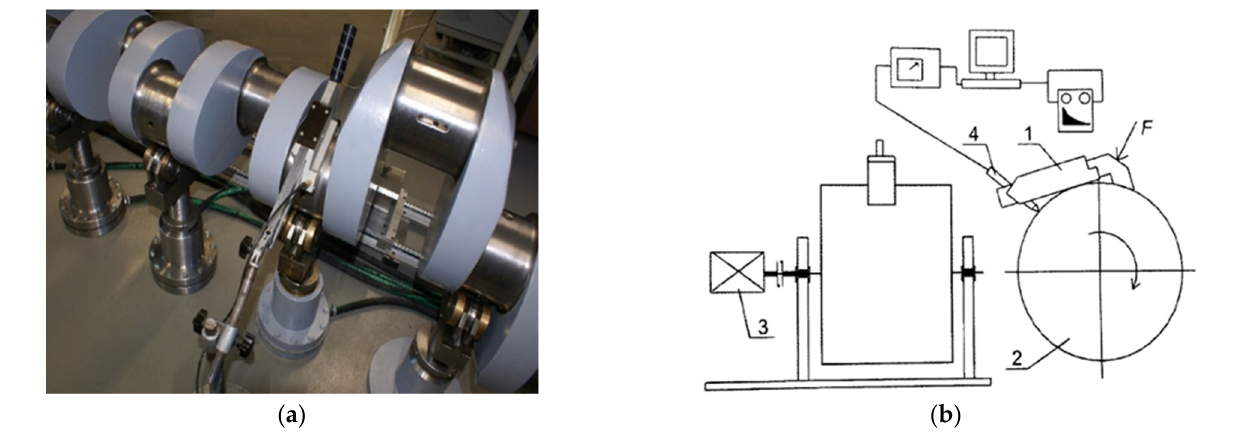
Figure 16. Measurements of the engine crankshaft with a MUK 26-600 sampling cell ( a ), scheme of measuring system ( b ) (1—measuring head MUK 25-600, 2—crankshaft journal, 3—drive motor, 4—displacement sensor, F—measuring head processing force [35]).